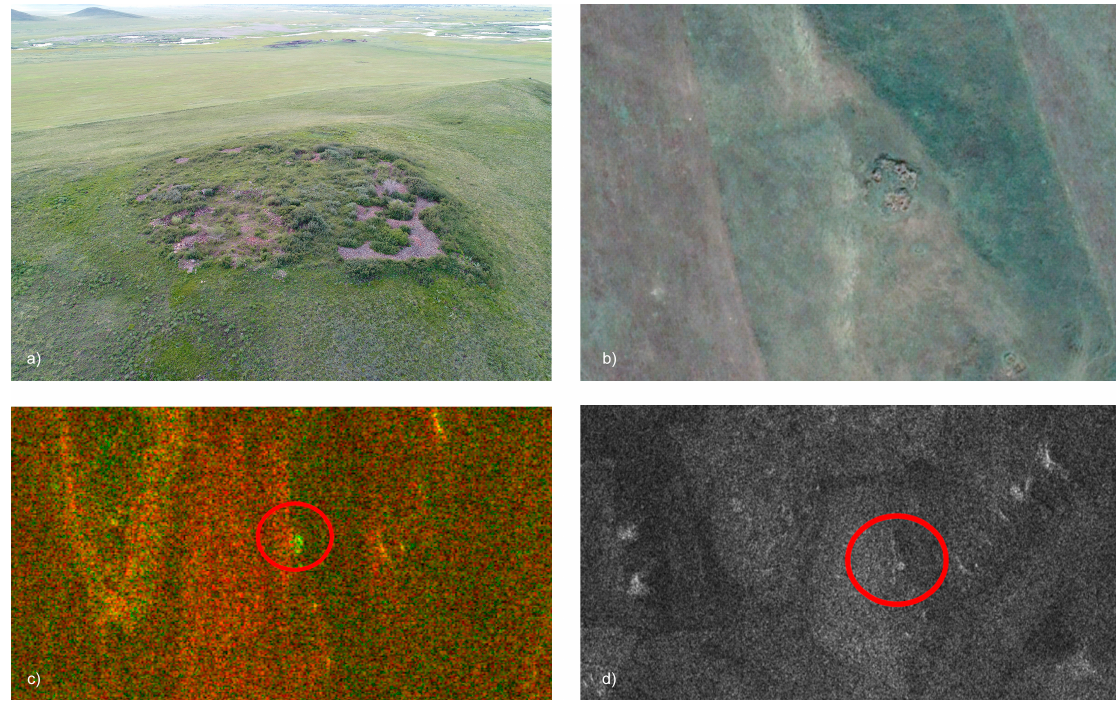
Figure 7. ( a ) The newly found archaeological structure on top of a hill near Torzh-hol (oblique drone shot); ( b ) the Torzh-hol structure from high-resolution open-source optical satellite imagery ( © CNES / Airbus 2019); ( c ) PALSAR-2 slant-range image; ( d ) archaeological structure in the TerraSAR-X image. Red: HH; green: HV; blue: 0 ( © JAXA). TerraSAR-X slant-range image ( © DLR, 2013).